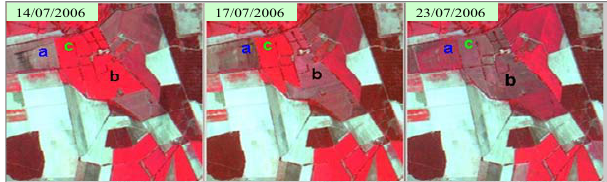
Figure 1 . Location of the studied area, and the footprint of the FORMOSAT-2 image.